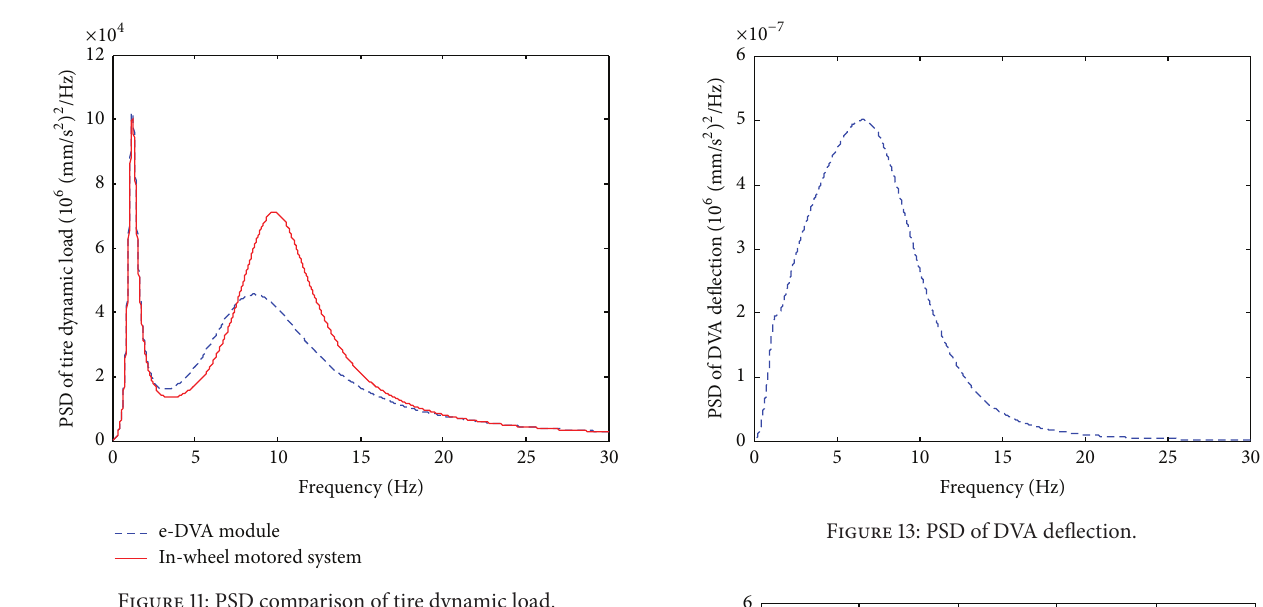
Figure 11: PSD comparison of tire dynamic load.